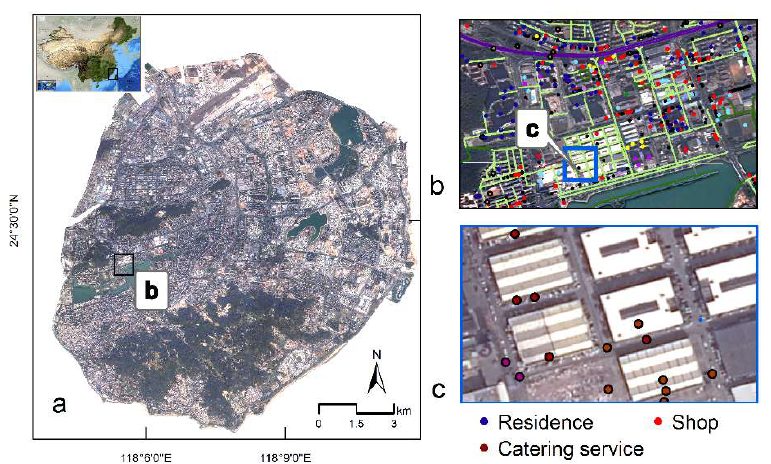
Figure 2. ( a ) High-resolution images from GaoFen-2 (GF-2) covering Xiamen Island; ( b ) a sample area showing detailed information about points of interests (POIs) and roads; ( c ) a sample area showing detailed information about POIs overlaid with buildings.